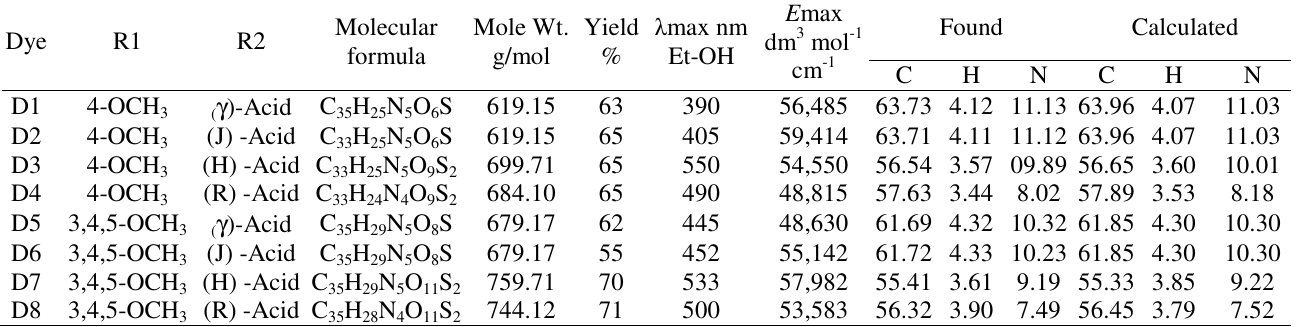
Table 3. Characterization of dyes